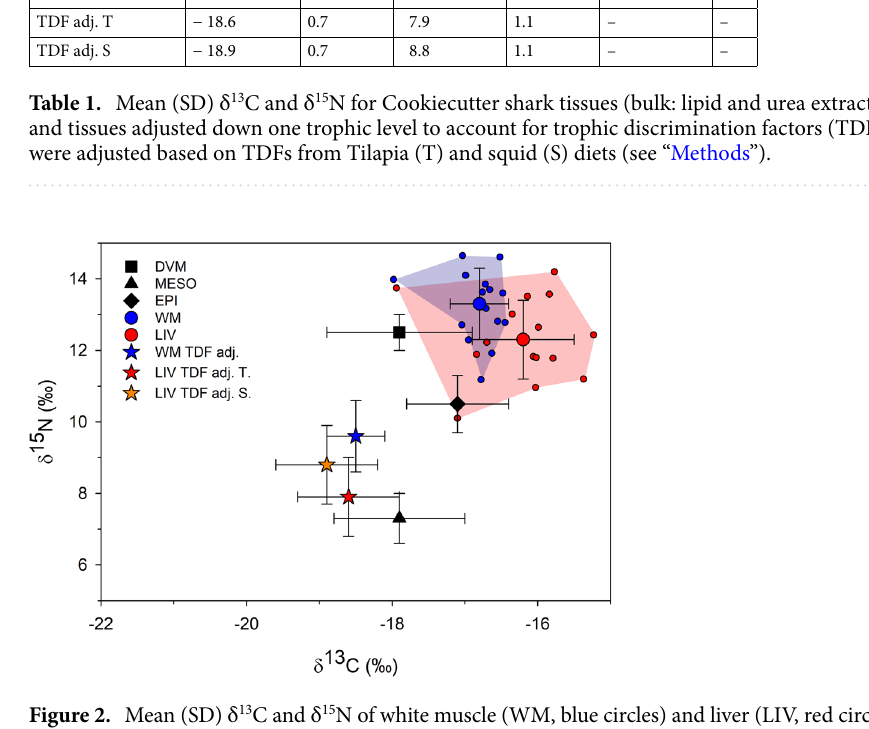
Figure 2. Mean (SD) δ 13 C and δ 15 N of white muscle (WM, blue circles) and liver (LIV, red circles) of Cookiecutter sharks and primary prey groups (black symbols). Blue and red circles show data for individual sharks, with the minimum convex polygons (MCP) for each tissue being shown by the polygons. The mean values for shark tissues were adjusted down one trophic level to account for trophic discrimination factors (TDFs) based on Kim et al. 53 for WM (blue star) and TDFs from this study for LIV based on Tilapia (red star, LIV TDF adj. T.) and squid (orange star, LIV TDF adj.